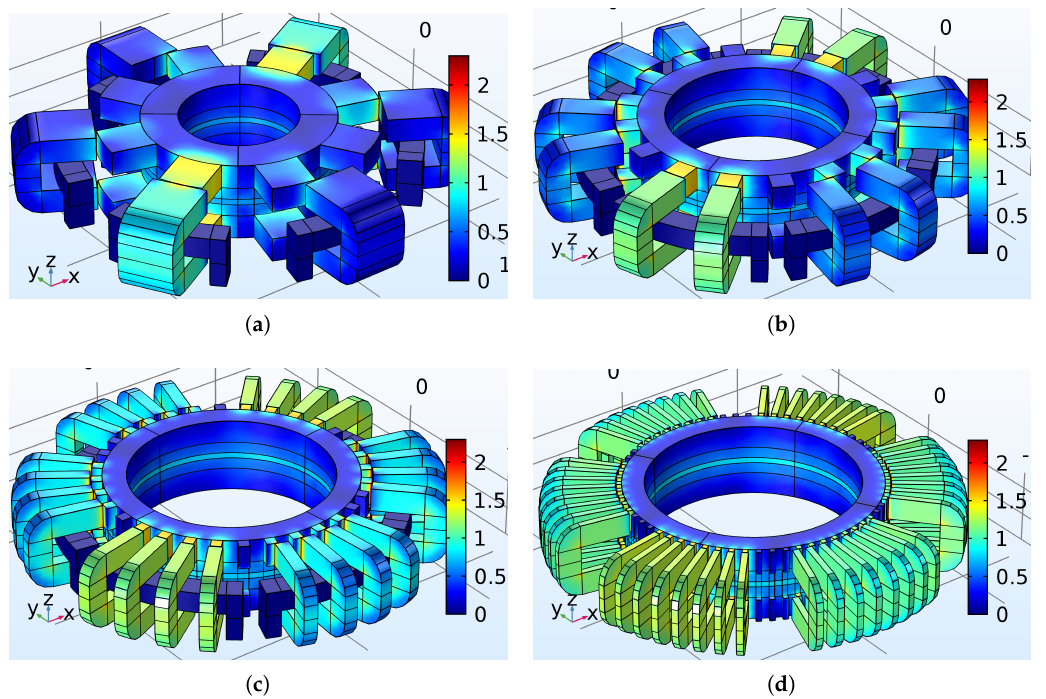
Figure 9. Magnetic flux density distribution of the HM3D machine at no-load; ( a ) original geometry, ( b ) n seg = 2, ( c ) n seg = 4, and ( d ) n seg =